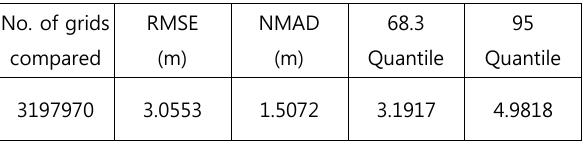
Table 2. Accuracy assessment of UAV stereo images